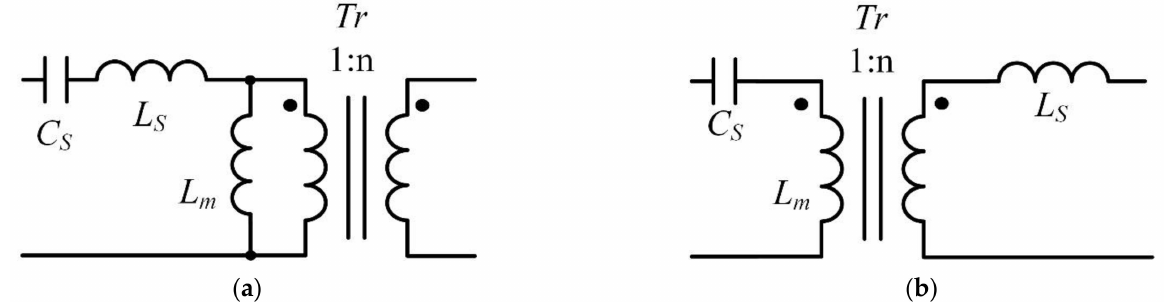
Figure 2. Circuit diagrams of the Type-4 and Type-11 resonant tanks. ( a )Type-4 LLC Resonant Tank; ( b ) Type-11 LLC Resonant